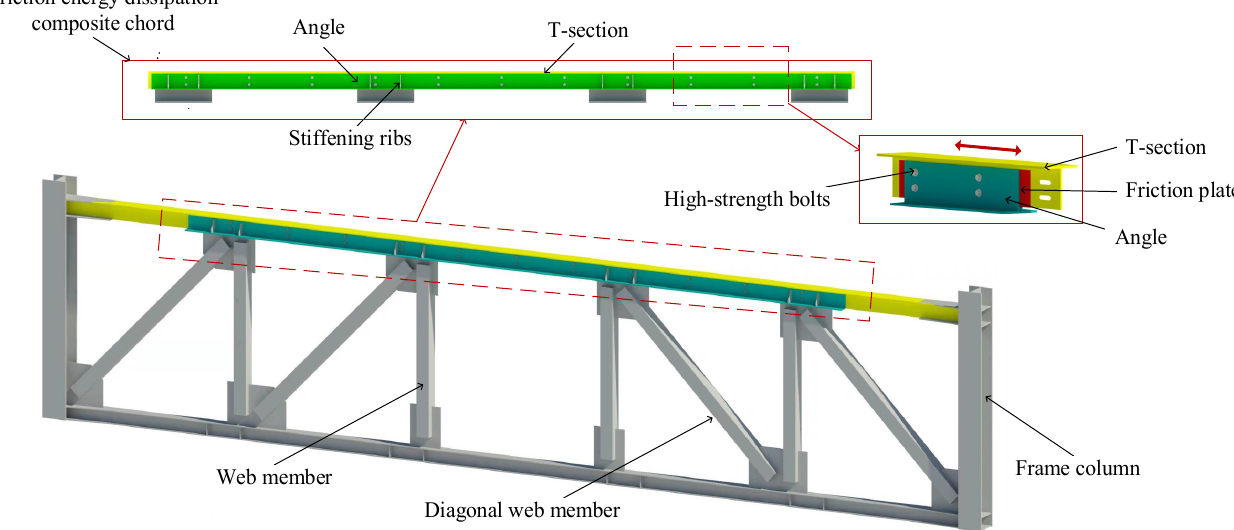
Figure 2. The structure diagram of the friction energy dissipation composite